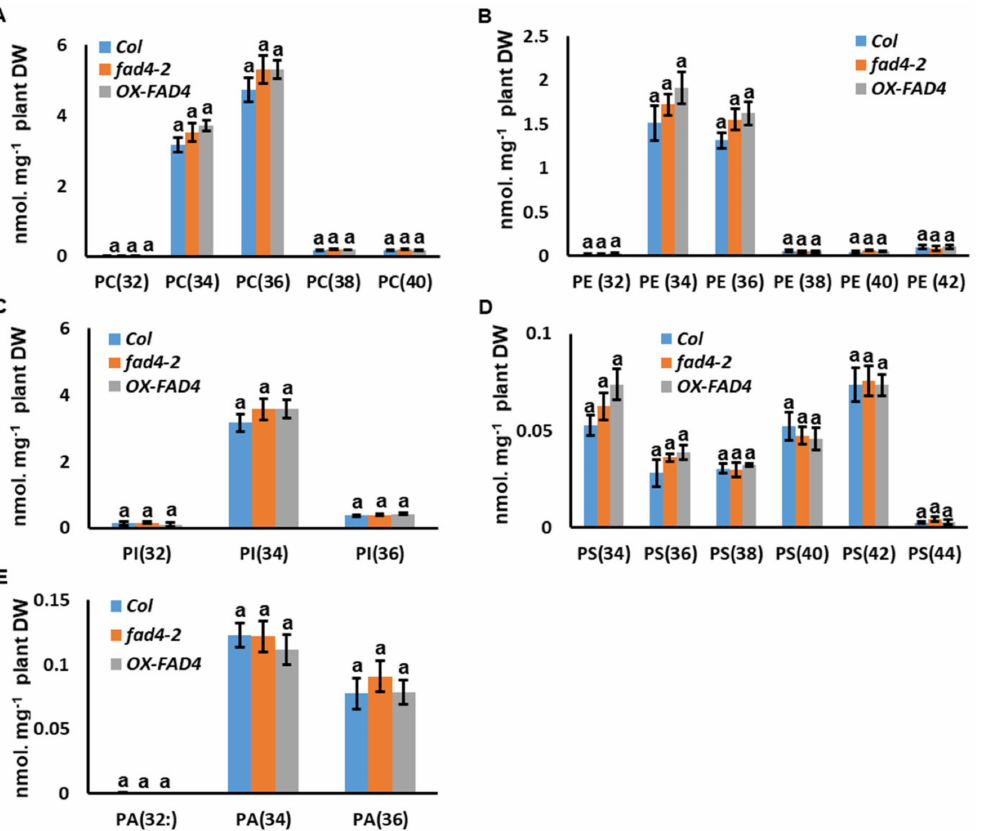
Figure 9. The molecular species contents of PC ( A ), PE ( B ), PI ( C ), PS ( D ), and PA ( E ) from WT, fad42 , and OX - FAD4_2 plants. Different letters within the same molecular species represent statistically significant